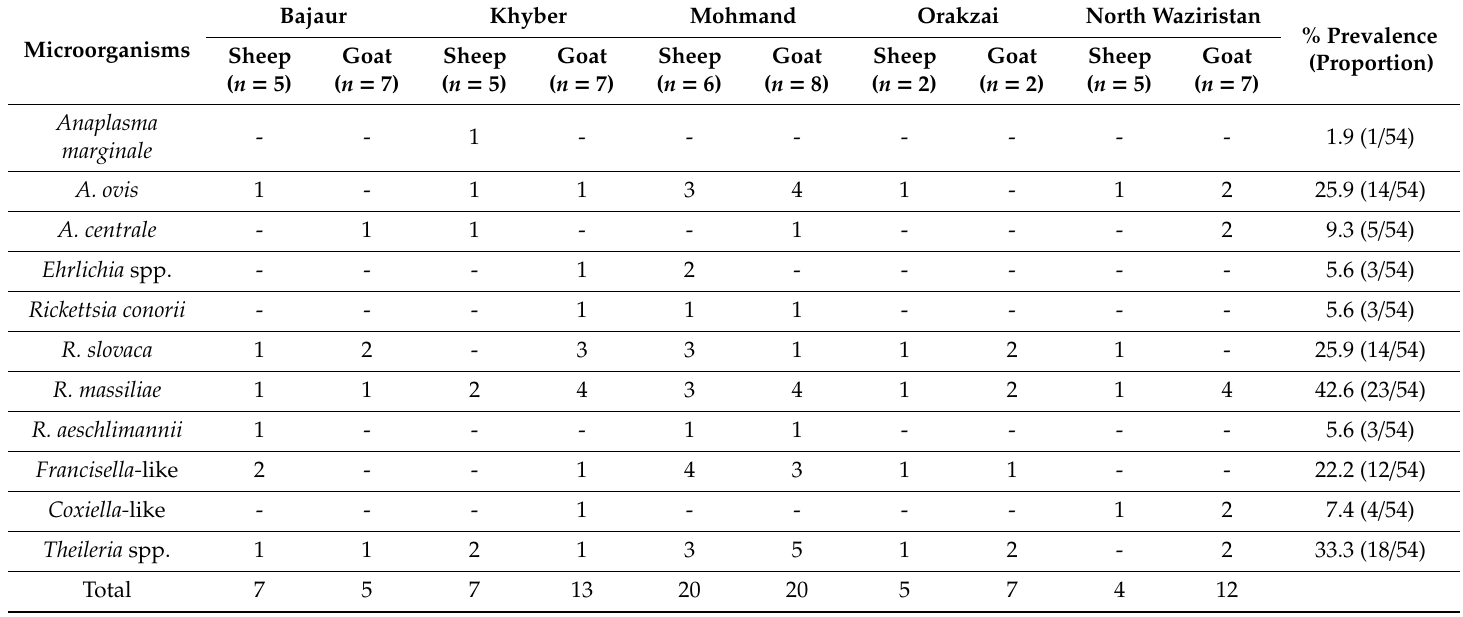
Table 3. Prevalence of microorganisms in ticks of small ruminants in the FATA of Pakistan. Bajaur Khyber Microorganisms